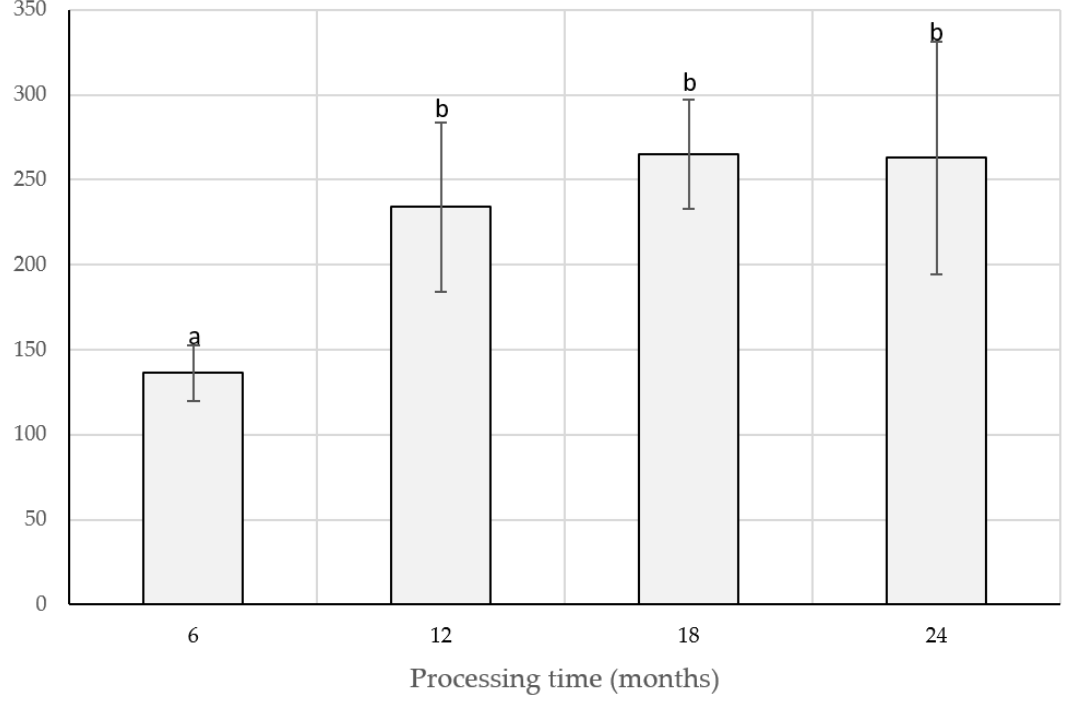
Figure 1. Evolution of AA concentration (µg/g Spanish dry-cured ham) during 6, 12, 18, and 24 months of processing. Different letters indicate significant differences among the month values at p < 0.05. Reproduced from [90] with permission.